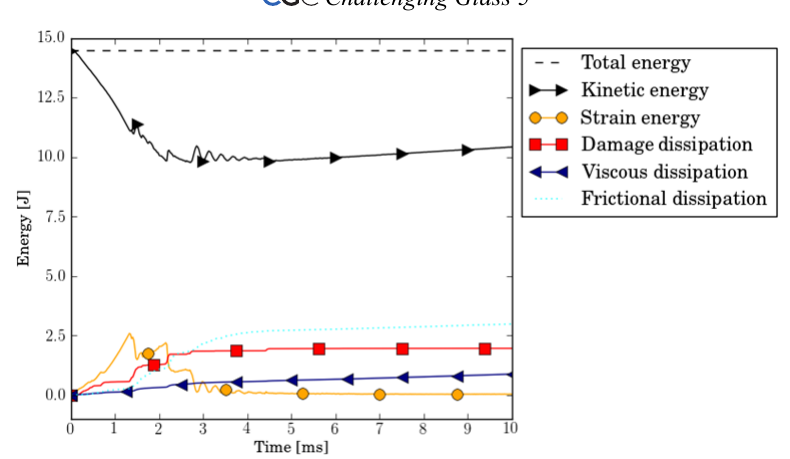
Fig. 16 Evolution of energies in simulation of glass with crack delay failure model under drop weight